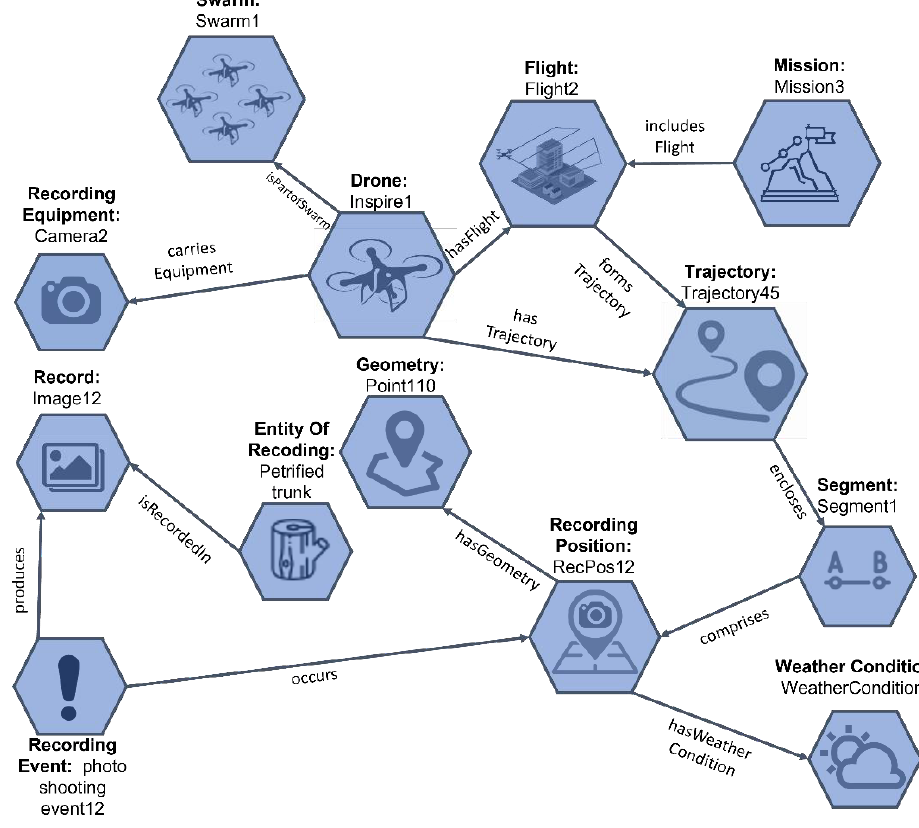
Figure 2. Graph representation of a UAV documentation flight over the Geopark of Lesvos.